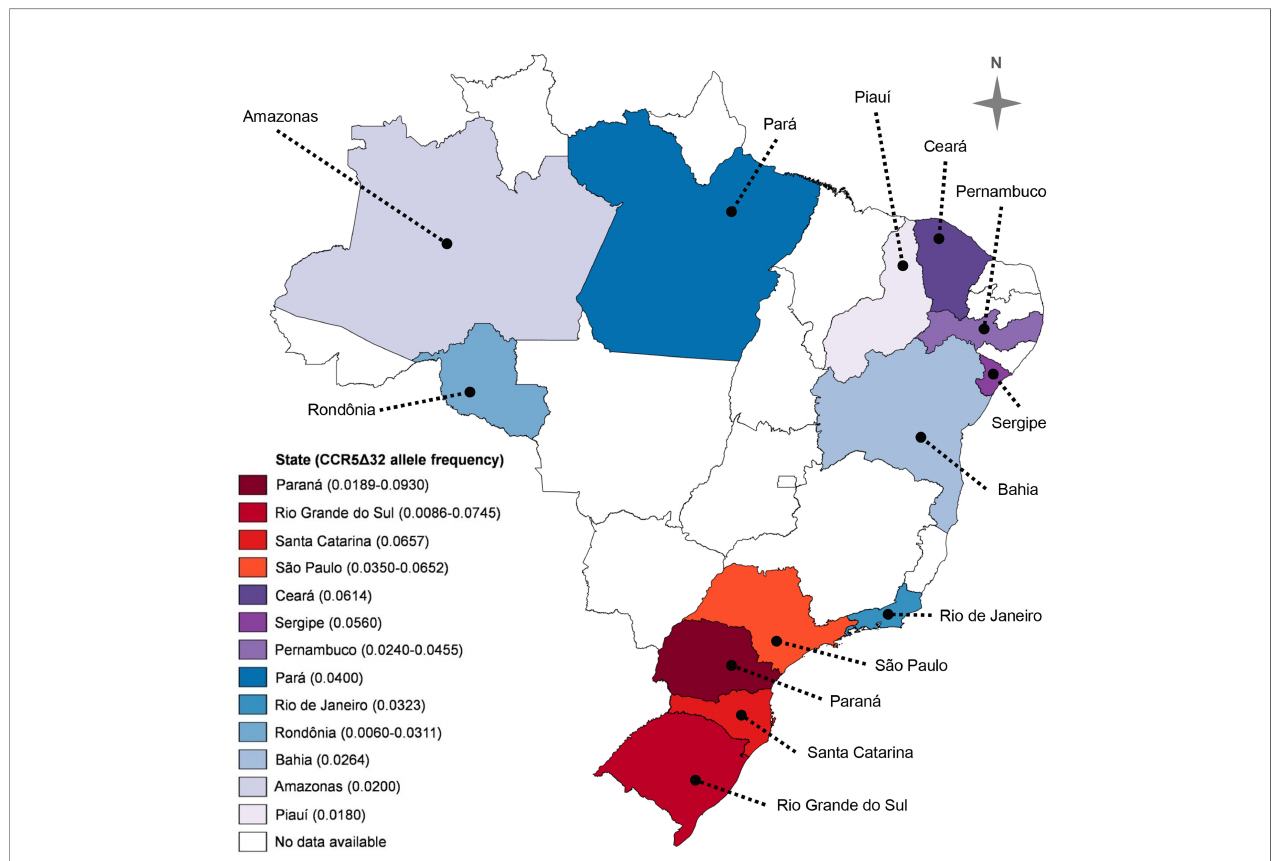
FIGURE 2 | CCR5 D 32 allele frequency in thirteen Brazilian states. Two values in parentheses represent the lowest and the highest frequency observed in a given state. Data from Silva-Carvalho et al. (49), Hüneimeier et al. (110) (Mura population; Amazonas State), Carvalho et al. (41) (Mocambo community; Sergipe State), and Ferreira-Fernandes et al. (111) (Piau ı ́ State). The map was created with the help of MapChart (https://mapchart.net/), licensed under a Creative Commons Attribution- ShareAlike 4.0 International